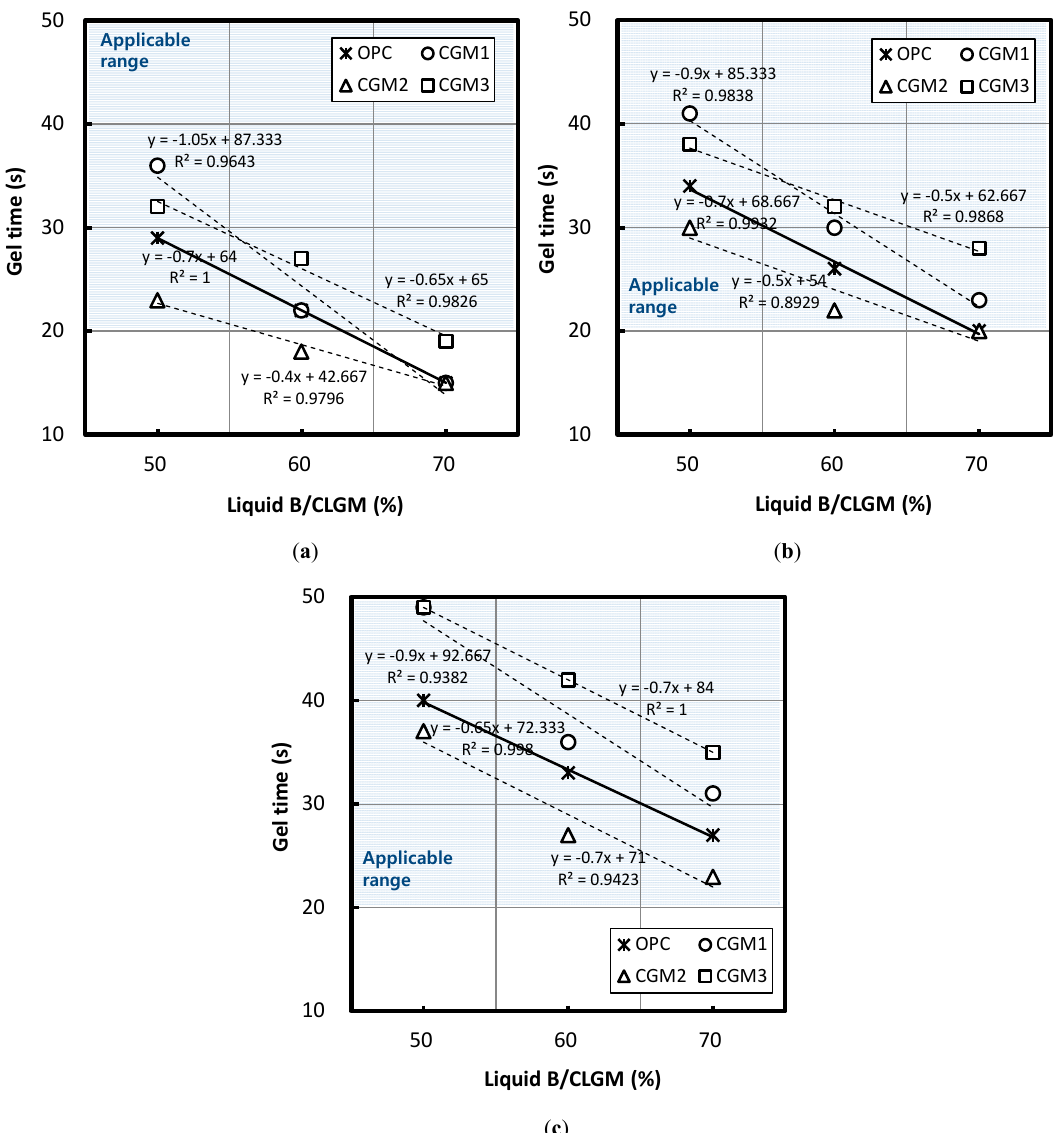
Figure 6. Gel time based on volume replacement ratio of Liquid B for a W / B ratio equal to ( a ) 100%, ( b ) 120%, and ( c ) 140%.